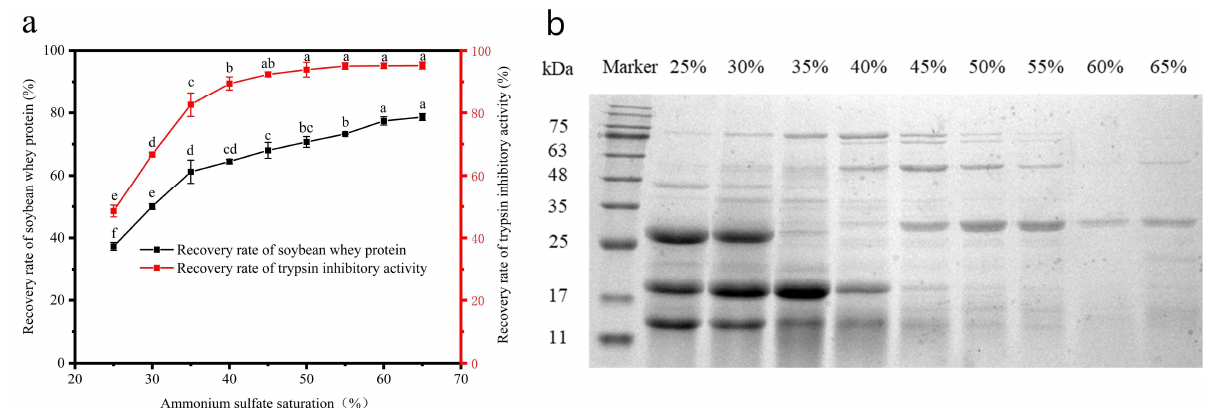
Figure 3. The effect of ammonium sulfate saturation on STI isolation and purification ( a ). The elec- trophoretic pattern of the protein isolated from the soybean whey via step-by-step ammonium sul- fate salting out ( b ). Different letters on the same series indicate significant differences ( p < 0.05) in varying conditions.